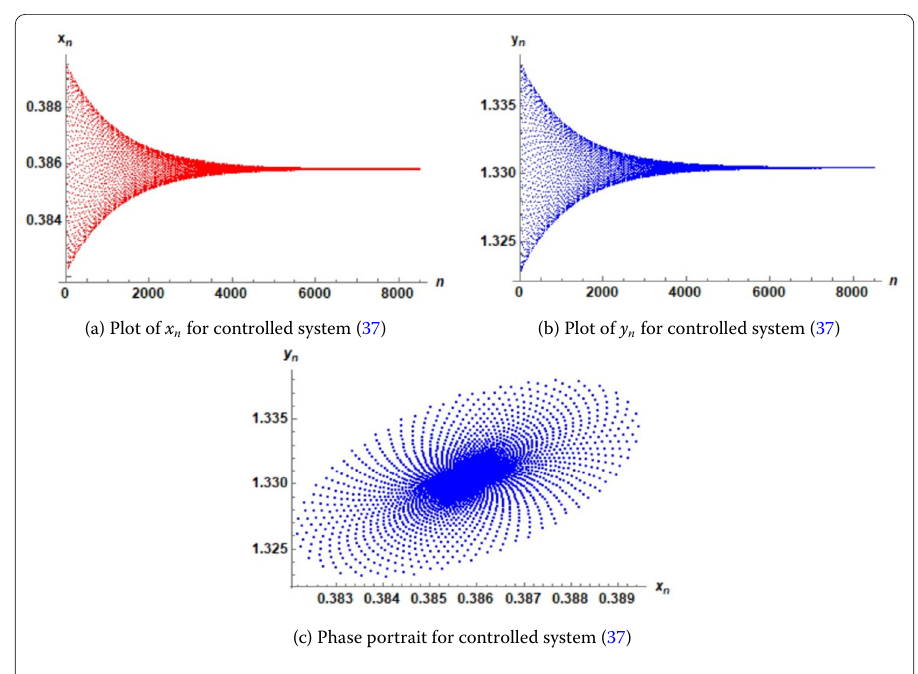
Figure 12 Plots and phase portrait for controlled system (37) with ( a , b , c , d , α , β ) = (0.001,0.75,0.224,0.29,0.19,1) and h = 0.5731 and initial